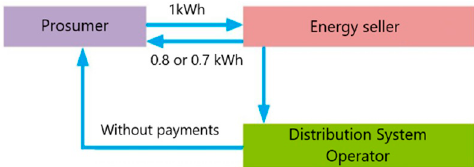
Figure 1. The diagram illustrates the rebate system for prosumers in Poland.